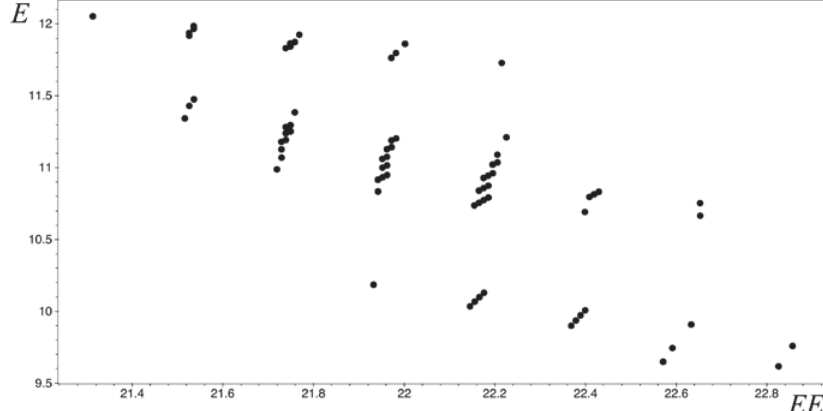
Figure 5. The relation between the Estrada index and the energy of a graph in the case of decanes.